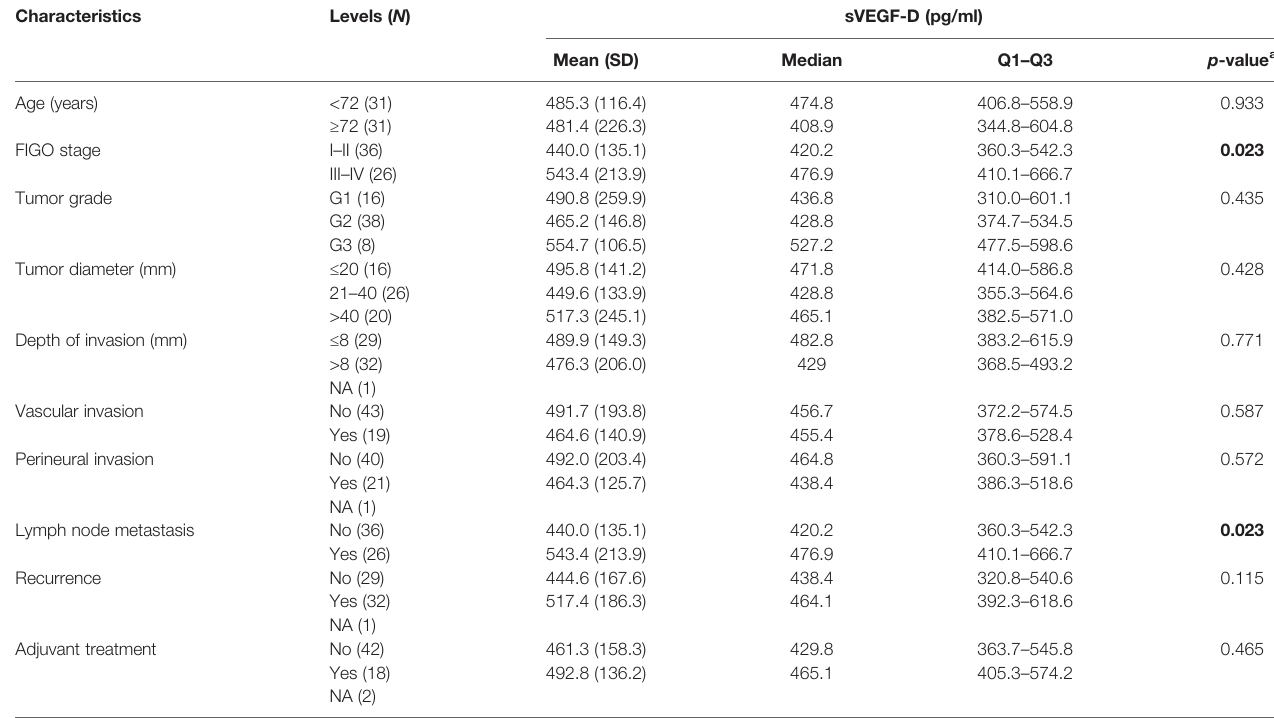
Signi fi cant p-values are indicated in bold. FIGO, International Federation of Gynecologists and Obstetricians; Q1, fi rst quartile; Q3, third quartile; NA, not available. a Linear model ANOVA on log2-transformed sVEGF-D